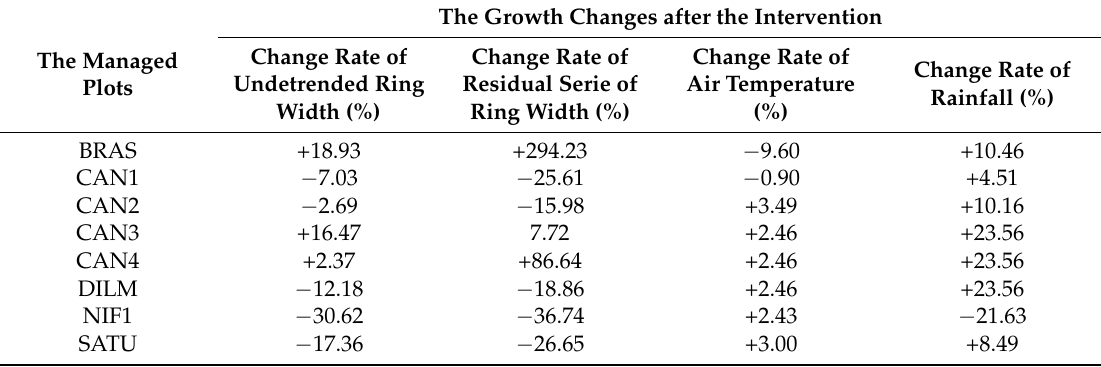
Table 4. The logging effects on the radial growth of